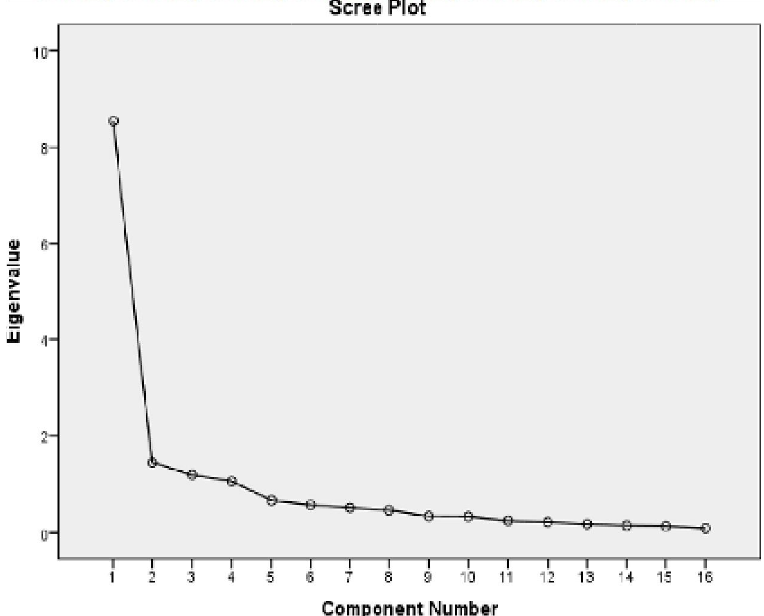
FIG. 1. SCREE PLOT (EIGEN VALUE AT A POINT DEPART FROM LINEARITY